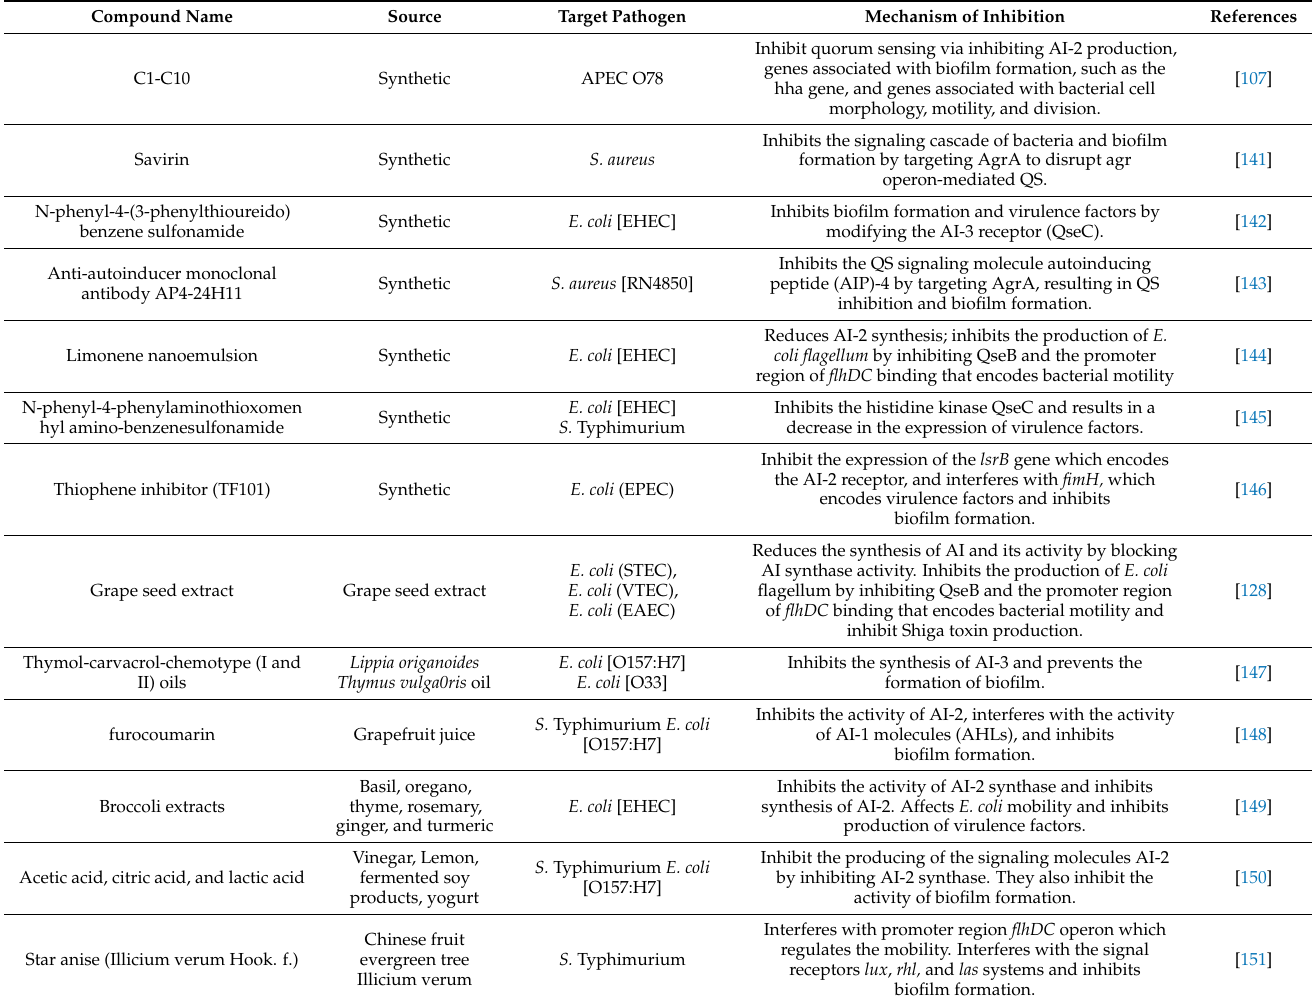
Table 2. Quorum-sensing inhibitors with their